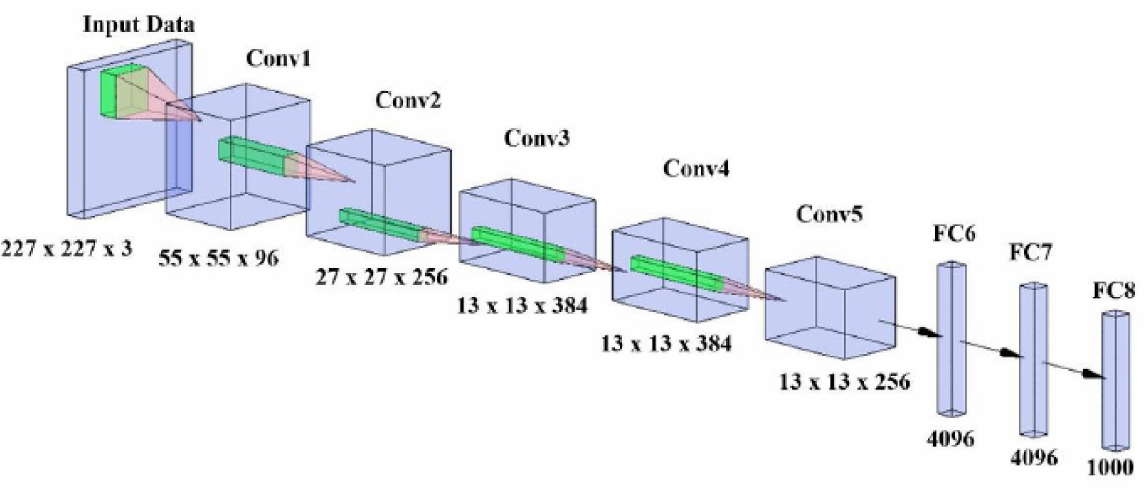
Figure A7. AlexNet architecture